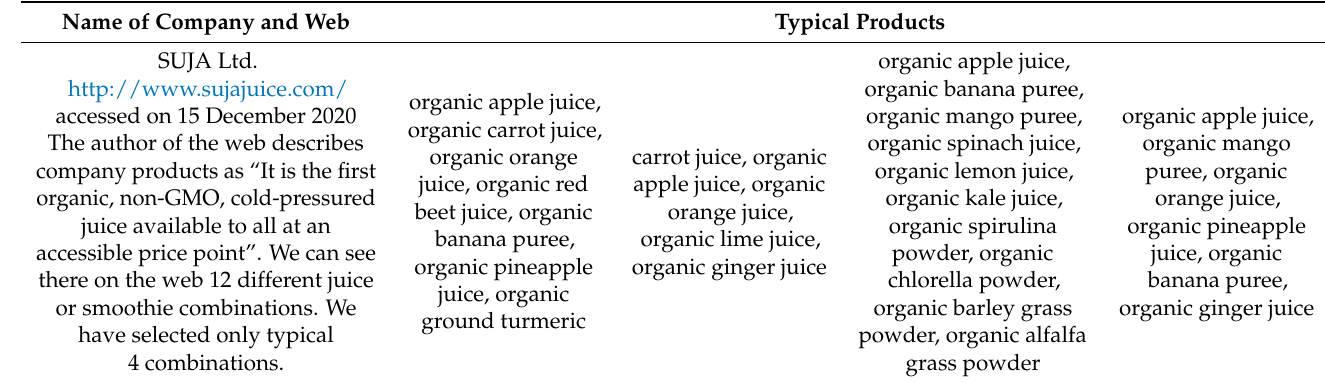
Table A12. High pressure treated products by the company SUJA.